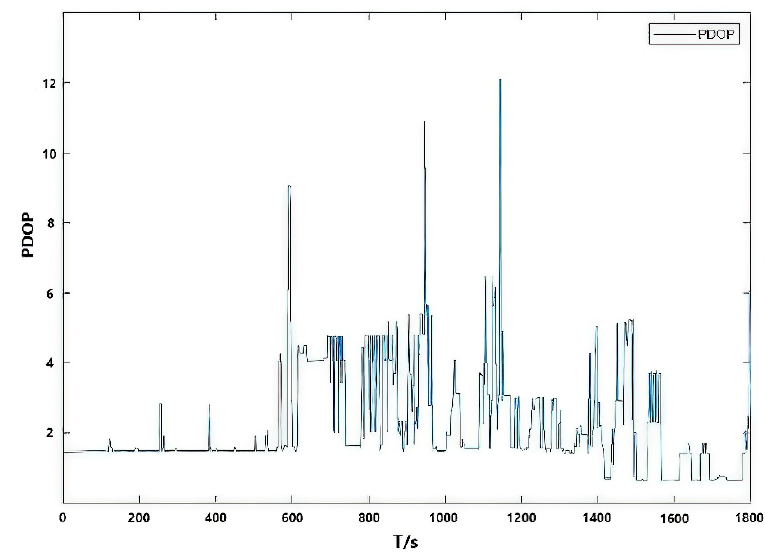
Figure 5. PDOP value in the urban experimental environment.